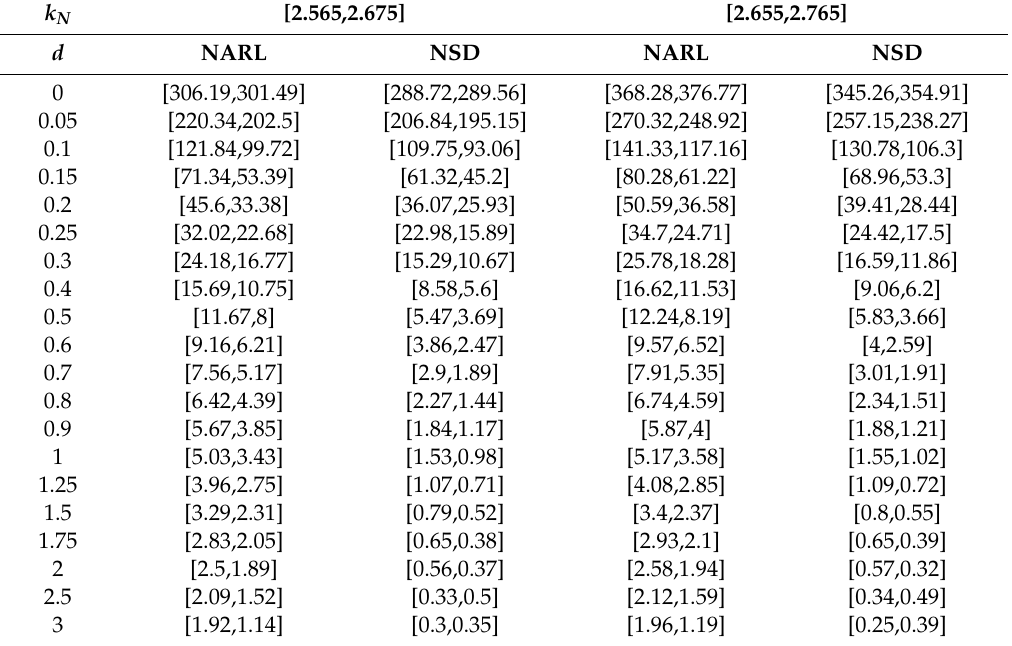
Table 1. The values neutrosophic average run length (NARL) and neutrosophic standard deviation (NSD) when n N (cid:15) [ 3,5 ] and λ N (cid:15) [ 0.08,0.12 ] . k